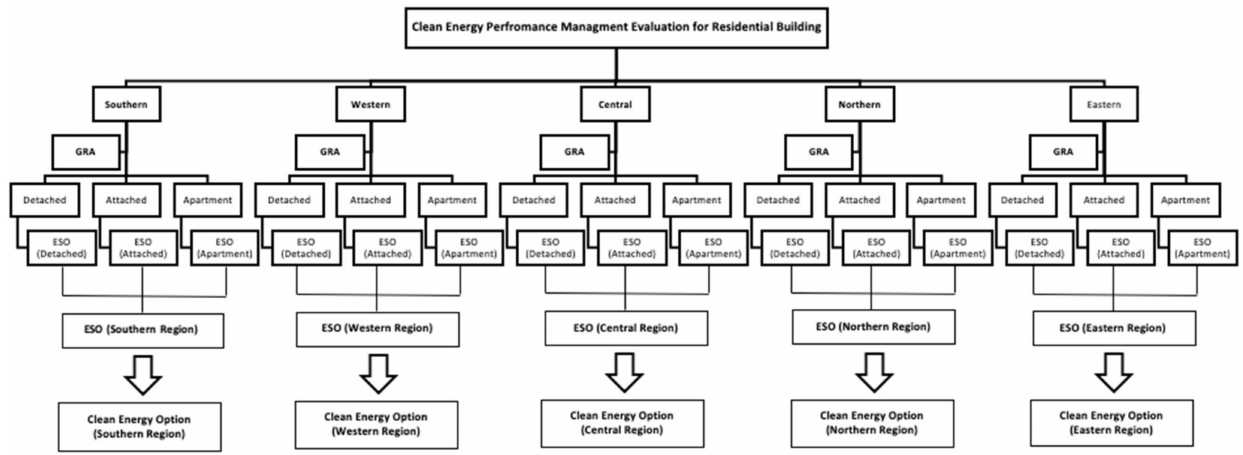
Figure 5. Clean energy option evaluation for the residential building based on